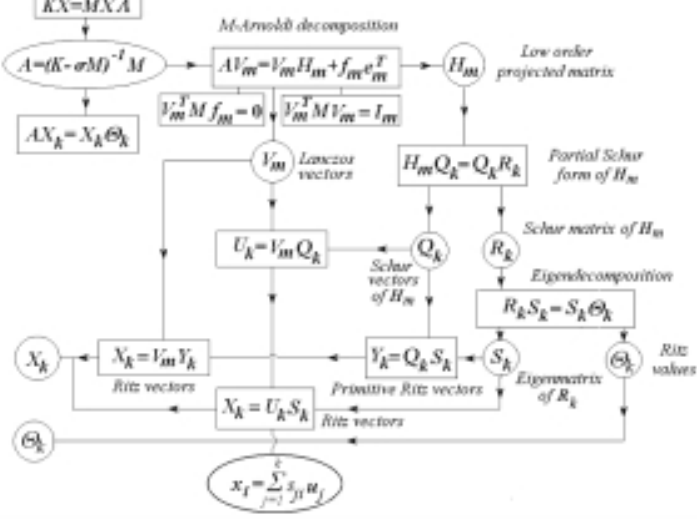
Fig. 3. Schematic of M -Arnoldi